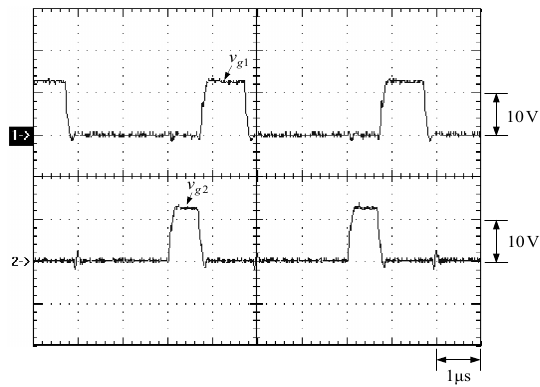
Figure 12. PWM signals for S 1 and S 2 : (1) v g 1 ; (2) v g 2 .